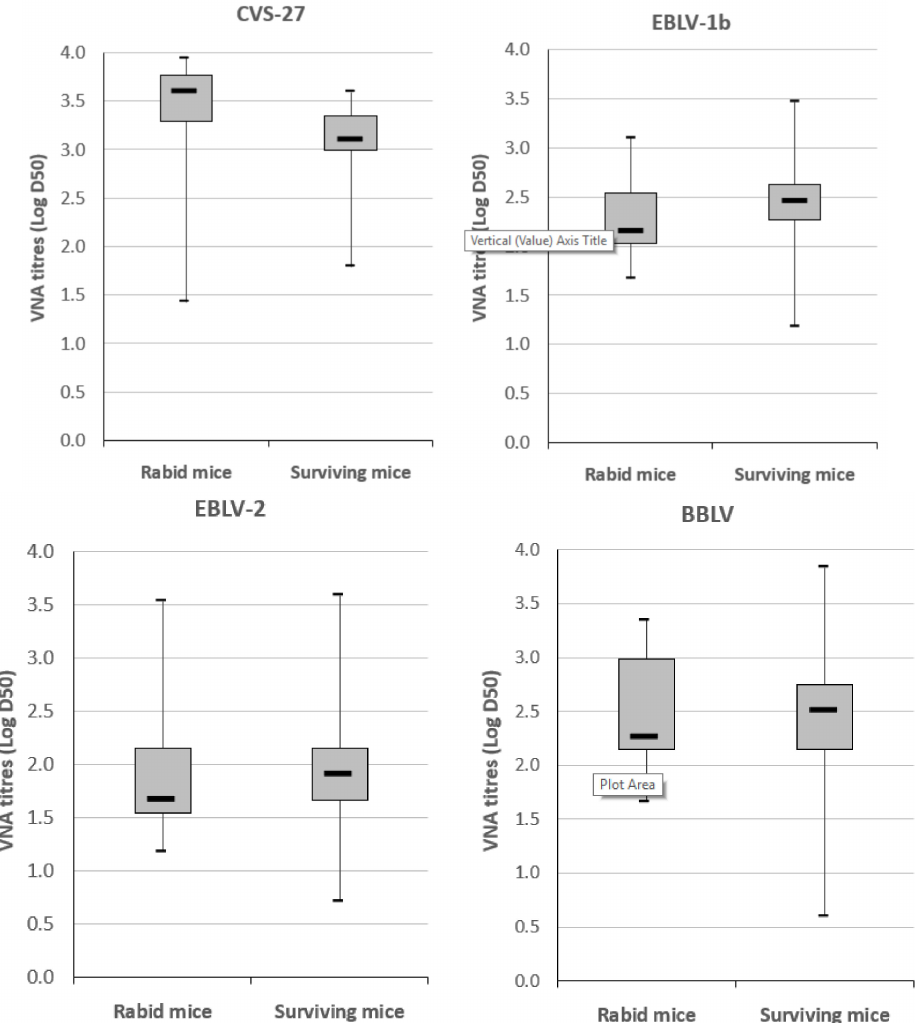
Figure 2. Comparison of VNA titers (log D50) in immunized mice that survived or succumbed to lyssavirus challenge (CVS-27, EBLV-1b, EBLV-2, or BBLV). Boxes represent the first and third quartiles and the line within the box represents the median value. Whiskers above and below the box show the locations of the minimum and maximum